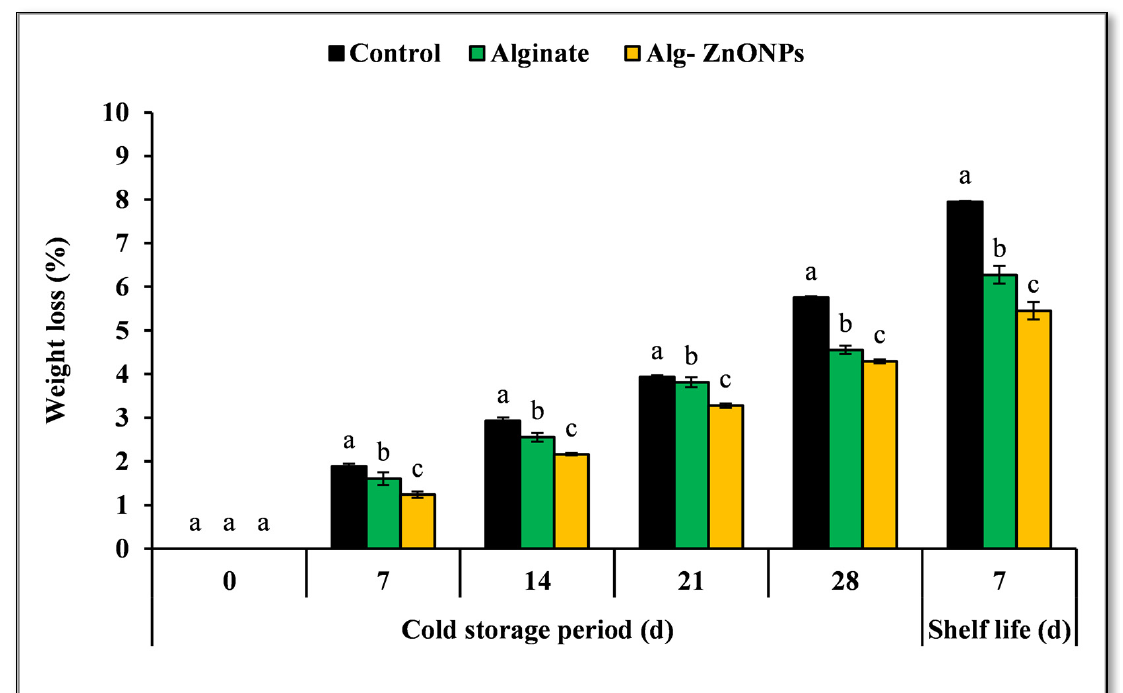
Figure 8. Effect of Alg–ZnO NPs on weight loss of “Kiett” mango fruits during cold storage and shelf life; vertical bars represent the standard error (SE). Bars marked with the same letter in each sampling date are not significantly different with 95% confidence according to Duncan’s multiple range test.